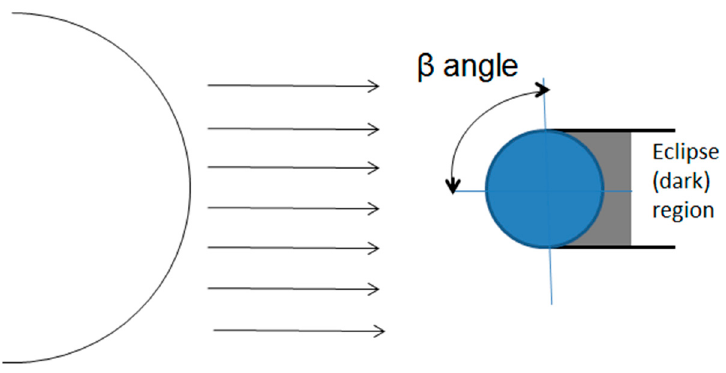
Figure 48. Shadow “eclipse zone” for Sun-synchronous Orbit [10].